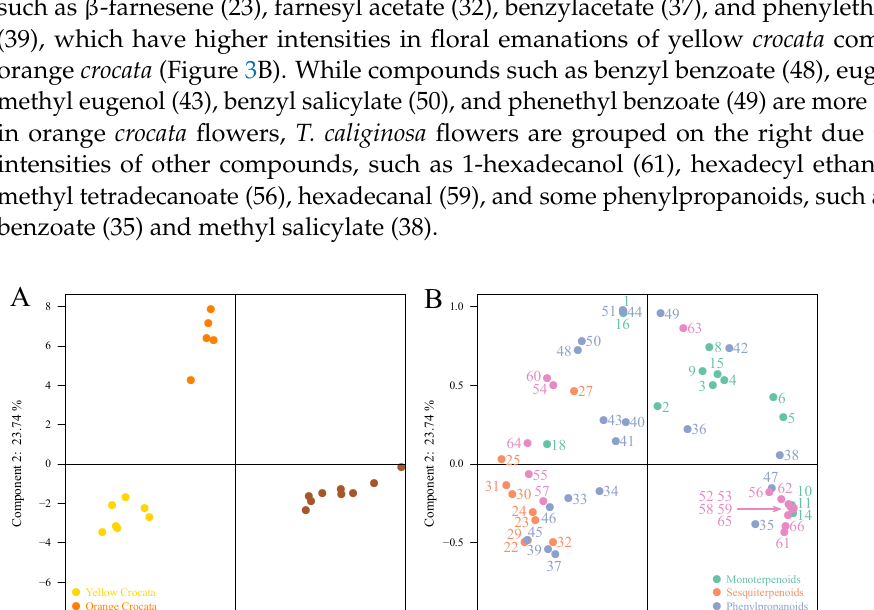
Figure 2. PCA based on VOCs emitted from yellow crocata, orange crocata, caliginosa, HP-xiphi and LP-xiphi: ( A ) Score plot of PC1 versus PC2 scores. ( B ) Loading plot of PC1 and PC2 contributing volatile compounds.